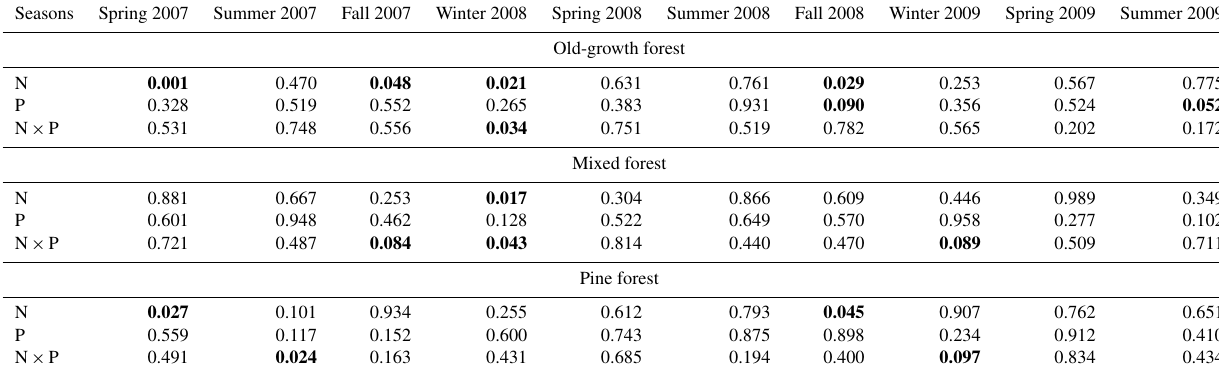
Table 3. P value of two-way repeated-measures ANOVA of seasonal N 2 O fluxes in the three study forests.